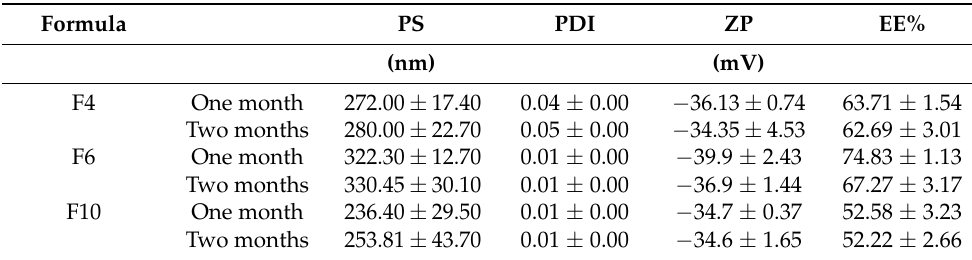
Table 5. Short-term stability study results for F4, F6, and F10 at 4 ◦ C after one and two months. Results are represented by mean ± SD ( n =